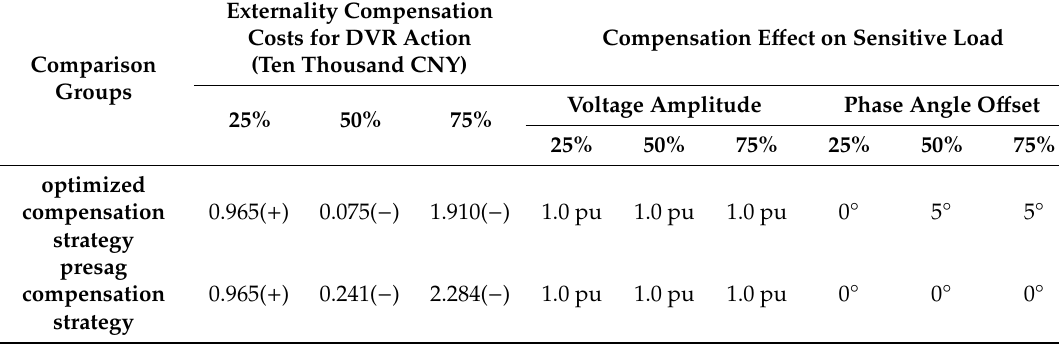
Table 5. Comparison between optimized compensation strategy and presag compensation